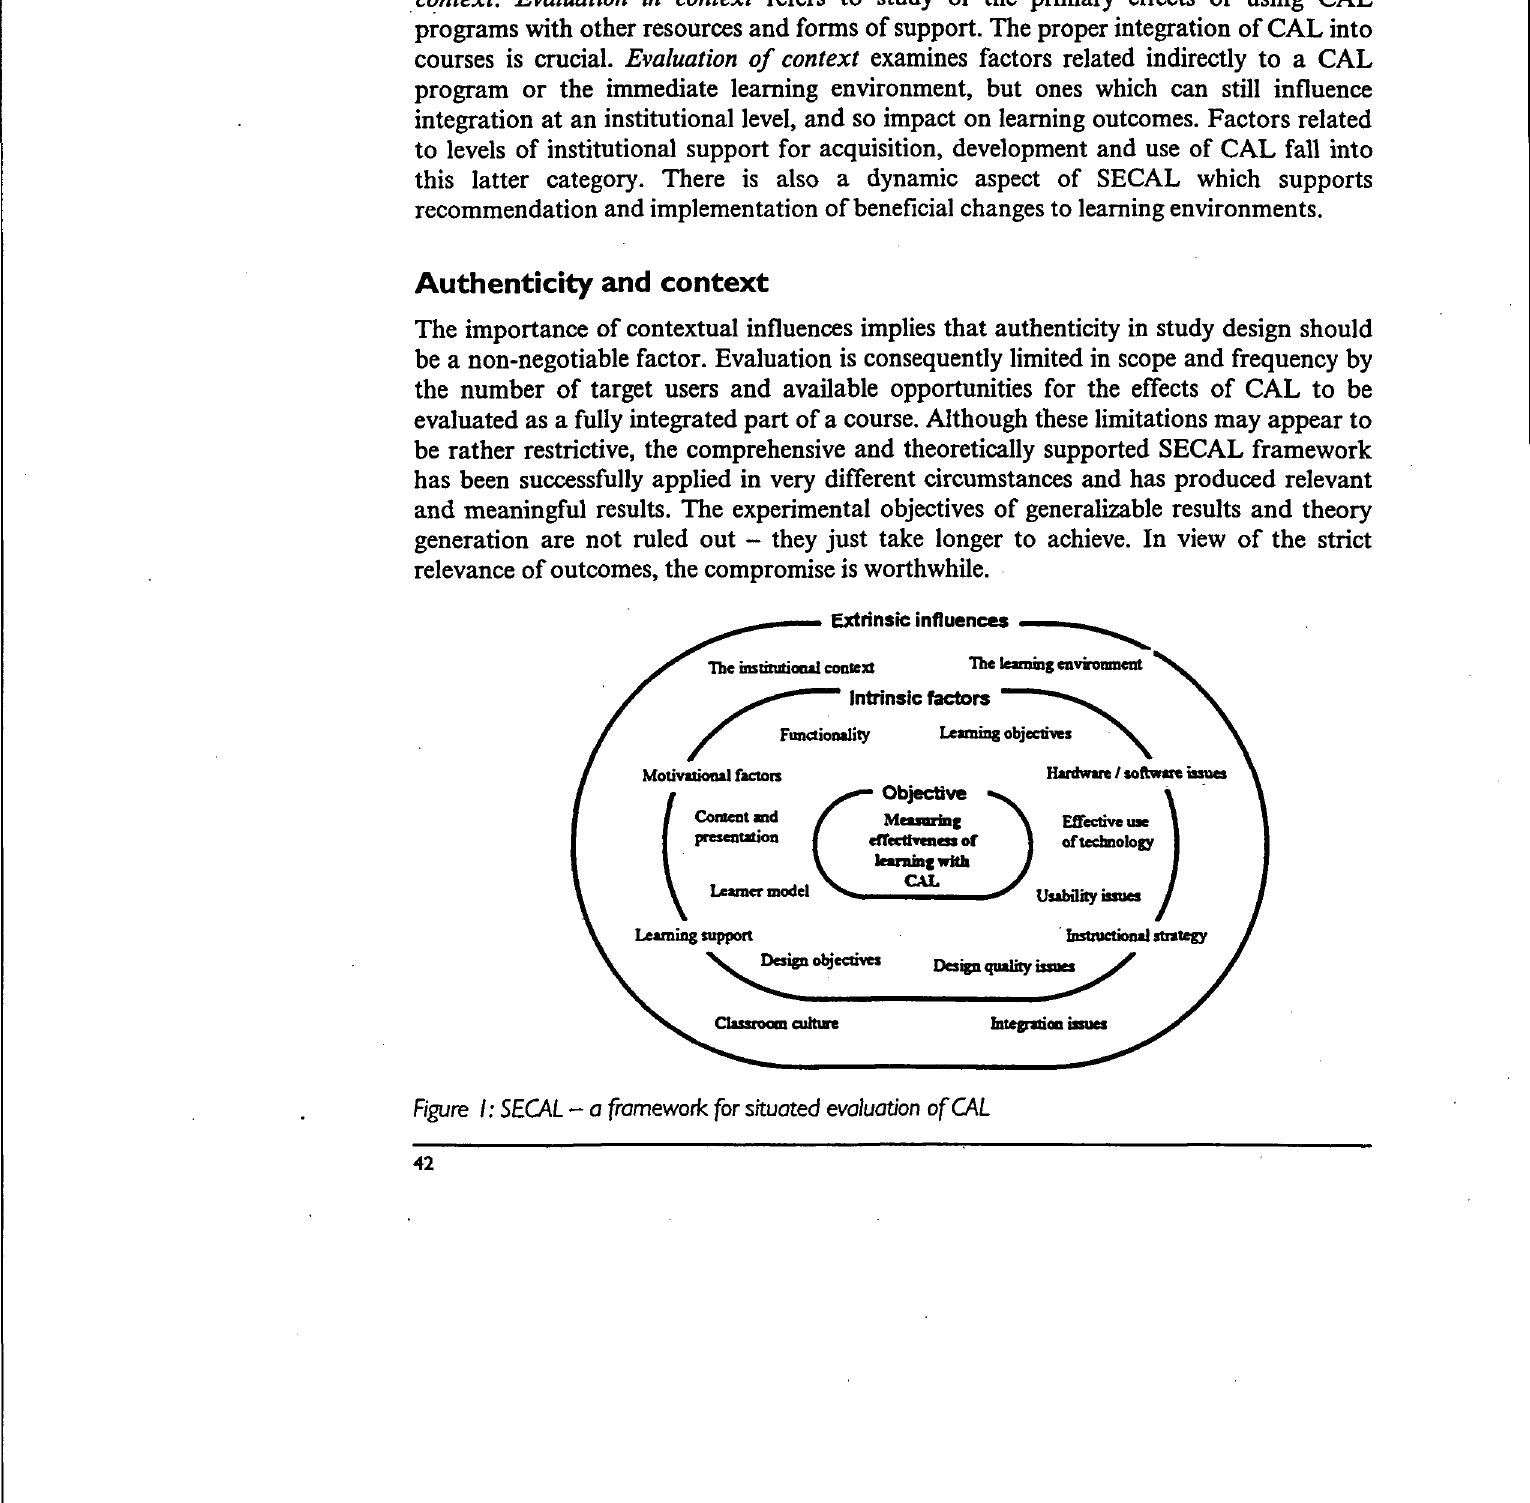
Figure /: SECAL - a framework for situated evaluation of